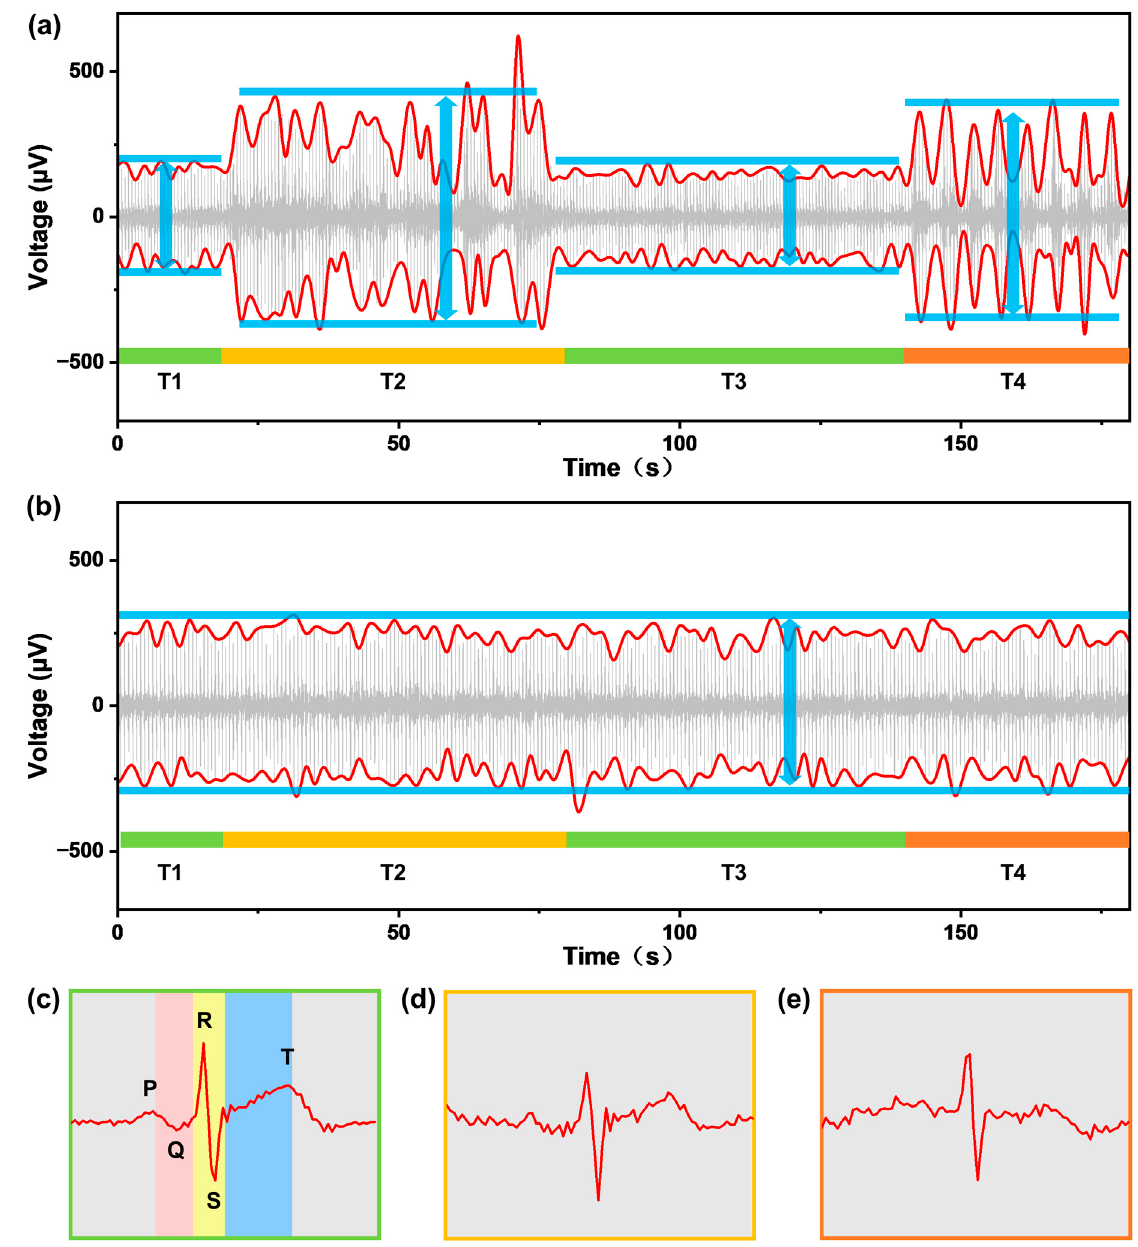
Figure 9. ( a ) ECG measurement with the CEP attached to the wrist. ( b ) ECG measurement with the NEH self-adhesive electrode attached to the wrist. ECG was obtained in three states: ( c ) static, ( d ) bending arm at 0.1 Hz, ( e ) bending arm at 0.2 Hz. The arrows represent peak-to-peak values of signals acquired at different actions. The capitalized letters represent different actions: static (T1), bending arm at 0.1 Hz (T2), static (T3), and bending arm at 0.2 Hz (T4).